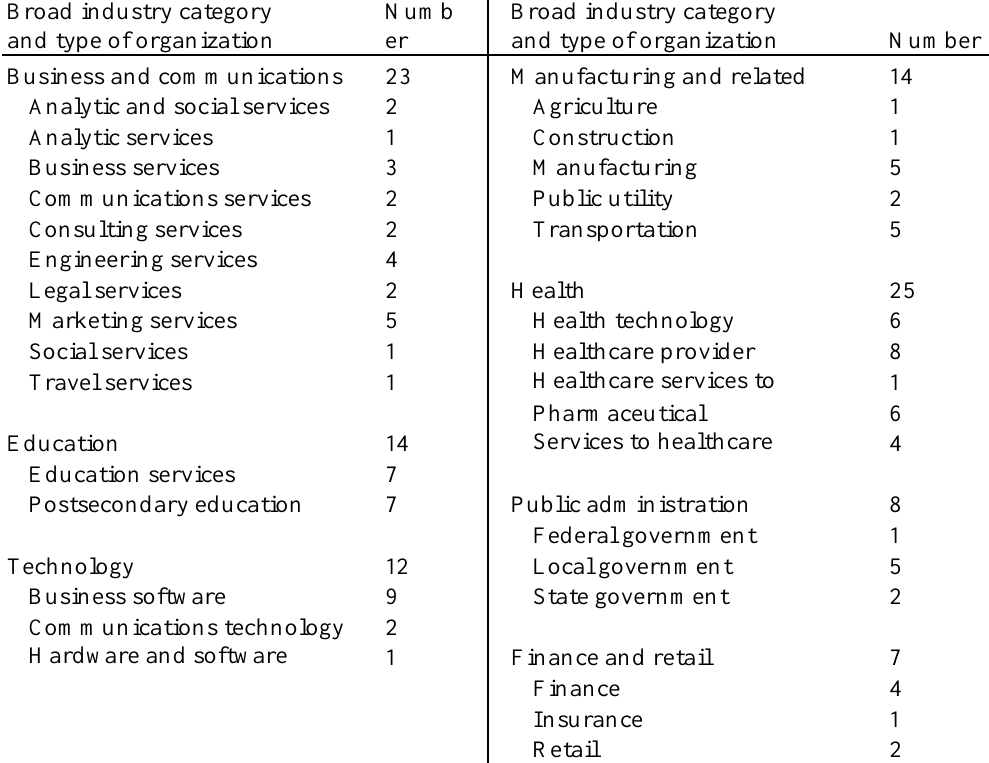
Among the 103 Organizations Surveyed, the Number Falling into each Broad Industry Category and More Detail on the Types of Organizations in that Category Broad industry